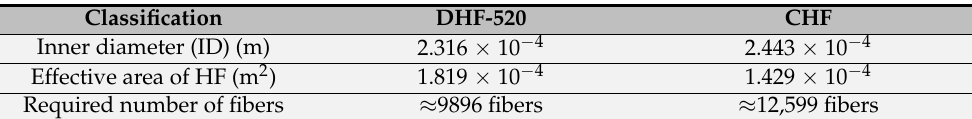
Table 5. Estimation of the required number of fibers to reach the assumption of a module with effective length of 0.25 m and membrane area of 1.8 m 2 .